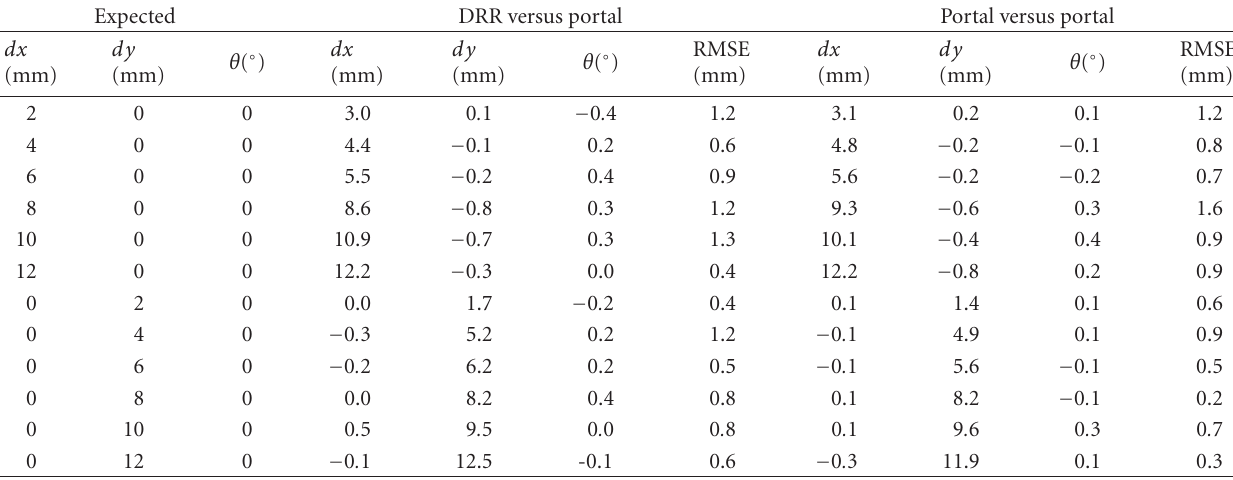
Table 1: Setup error estimations (horizontal displacement, vertical displacement, angle of rotation, and RMS error) for known setup error of the pelvic region of the phantom for DRR versus portal and portal versus portal.